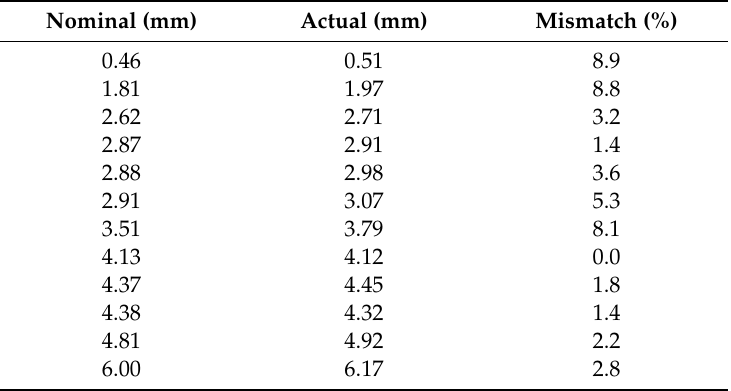
Figure 15. Example of the nominal cross-section corresponding to the actual cross-cut section. Table 2. Nominal vs average actual circle diameter (ordered by size) and corresponding mismatches. Nominal